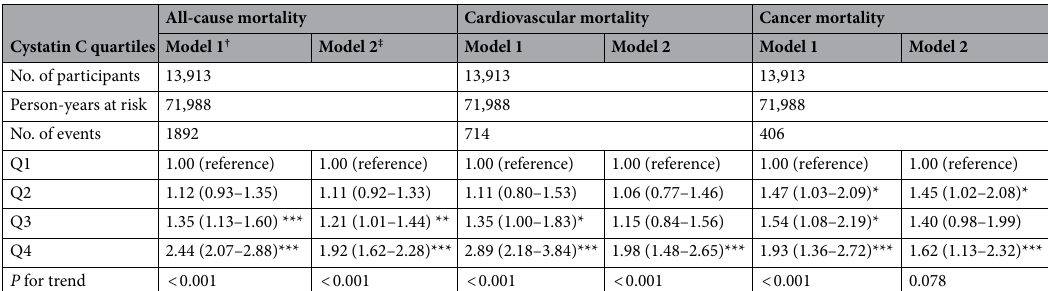
Table 2. HRs (95% CIs) for all-cause, cardiovascular and cancer mortality according to cystatin C concentration quartiles. HR: hazard ratio; CI: confidence interval. † Model 1: adjusted for age and sex. ‡ Model 2: adjusted for age, sex, race, educational level, current smoking status, alcohol consumption, regular exercise, body mass index, household income, total cholesterol concentration, high-sensitivity C-reactive protein concentration, high-density lipoprotein-cholesterol concentration, hemoglobin A1c, CES-D 8 score, hypertension, heart disease, stroke, cancer, diabetes, pulmonary disorders, psychiatric problems, and limitations in activities of daily living (ADLs). * P < 0.05; ** P < 0.01; *** P <